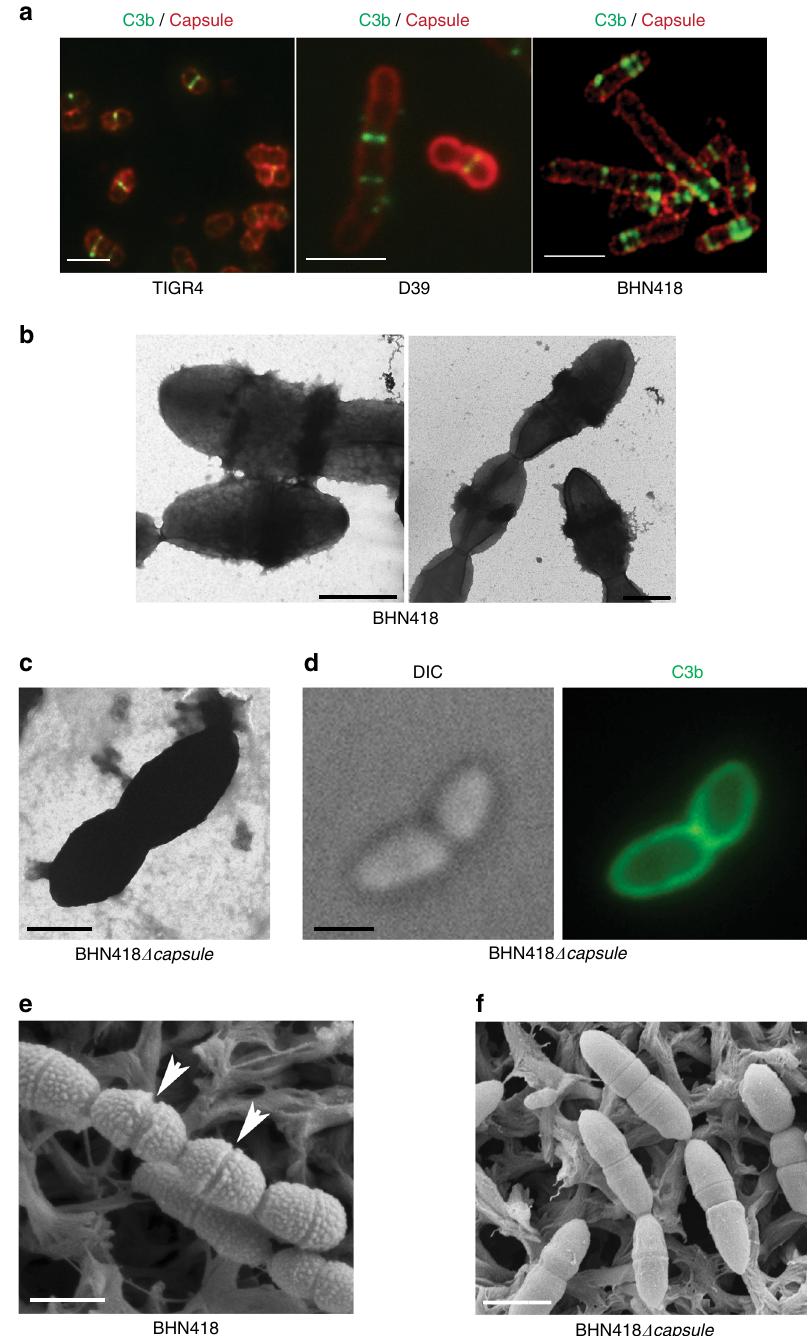
Fig. 1 Complement C3b deposition occurs at or close to division septa in encapsulated Streptococcus pneumoniae. a Representative immuno fl uorescence images showing distinct septal localization of C3b on pneumococcal strains TIGR4 (serotype 4), D39 (serotype 2) and BHN418 (serotype 6B). C3b was stained using goat anti-C3 antibody followed by incubation with anti-goat Alexa fl uor 488 secondary antibody (green). The capsule was detected using respective rabbit anti-capsule serum and anti-rabbit Alexa fl uor 594 antibody (red). Scale bar = 5 µ m. b Representative TEM images of wt BHN418 after incubation with 20% normal human serum. C3b deposits are seen as dark rings at division septa. c Representative TEM image of BHN418 Δ capsule after incubation with 20% normal human serum. A uniform deposit of C3b is observed. d Representative immuno fl uorescence images of C3b deposition on BHN418 Δ capsule after incubation with 20% normal human serum. C3b was stained using goat anti-C3 antibody followed by incubation with anti-goat Alexa fl uor 488 secondary antibody (green). e SEM images of wt BHN418. Arrows indicate two division septa lacking surface humps representing the capsule. f SEM images of BHN418 Δ capsule devoid of surface humps. b – f Scale bar = 1 µ